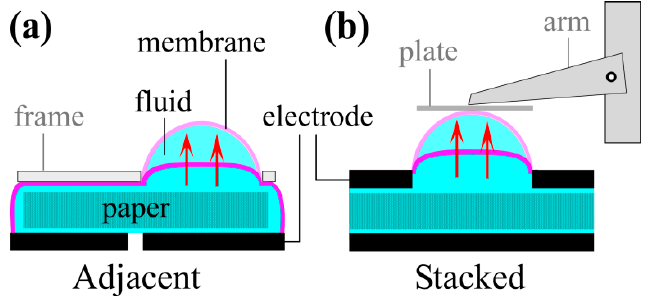
Figure 2. Device designs with ( a ) adjacent and ( b ) stacked electrodes. A paper microchannel layer is positioned between the electrodes. Fluid pumped through the paper inflates an elastomeric membrane. Force and deflection are measured using a transducer, the arm of which rests on a pressure-distributing plate placed on the membrane.